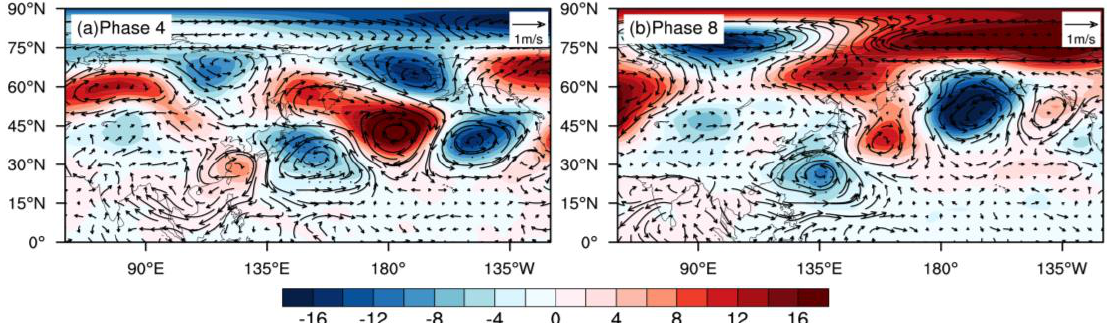
Figure 11. Composite 30 – 60 d filtered 500 hpa geopotential height fields (shading, units: gpm) and 850 hPa wind fields (vector, units: m/s) for ( a ) phase 4 and ( b ) phase 8 during the second type of PHTEs. Black dots represent geopotential height anomalies exceeding the 90% confidence level.